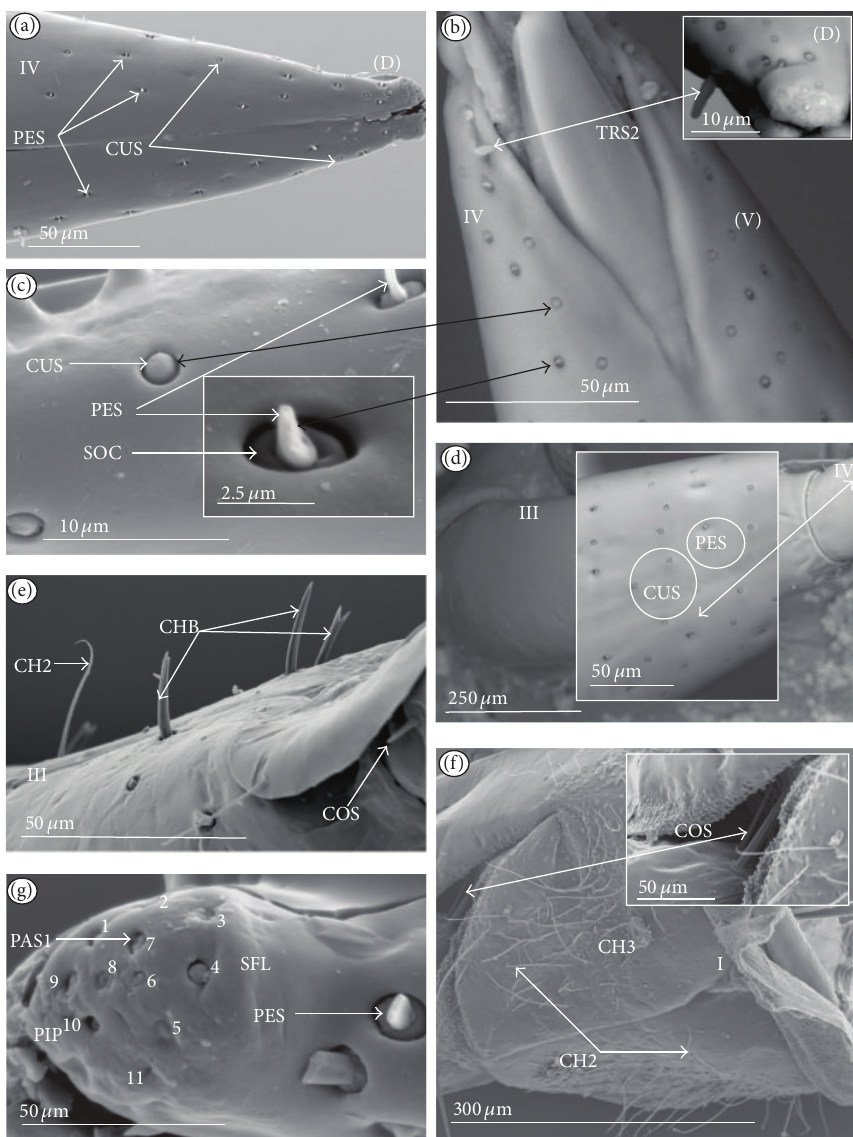
Figure 17: Types and sizes of the sensilla of the Gelastocoridae: Nerthrinae ( Nerthra nepaeformis ). (a) On the dorsal surface PES and CUS are numerous and evenly cover the IV segment of the labium. (b) TRS2 (one) is situated ventrally near the tip of the labium. (c) The shapes of CUS and PES, magnified. The socket is clearly visible. (d) PES and CUS are numerous and cover the ventral surface of the II and III segments. (e) CHB are unevenly distributed on the dorsal surface of the III segment, and COS (prioprereceptive sensilla) are situated on the dorsal surface of the IV segment near the base of the III segment. (f) CH2 are numerous and situated dorsally (D) on segment I of the labium, and COS are placed at the base of the edge of segment II. (g) PAS1 (no. 1–11) are distributed over